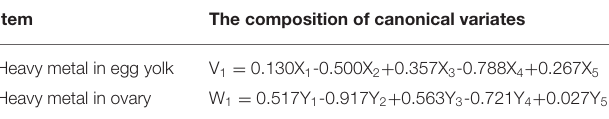
TABLE 8 | Composition of the first pair of typical variables of heavy metal concentration in the egg yolk and ovary. Item